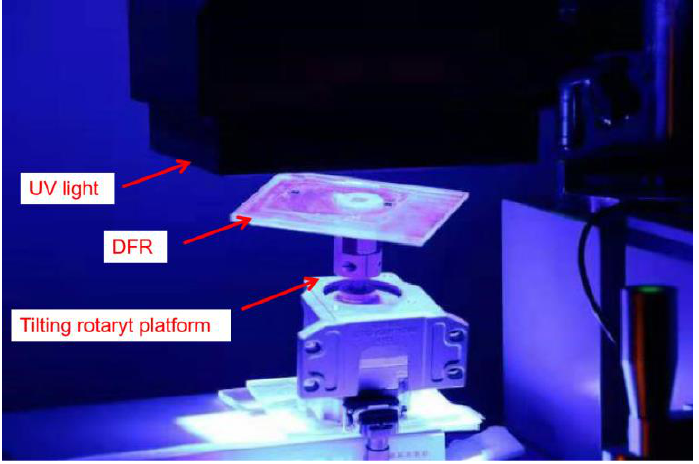
Figure 5. Tilting rotary Ultraviolet (UV) lithography platform.